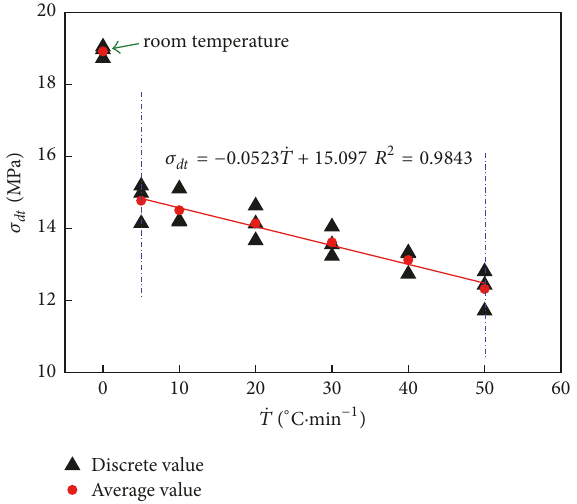
Figure 6: Variation of dynamic tensile strength with heating